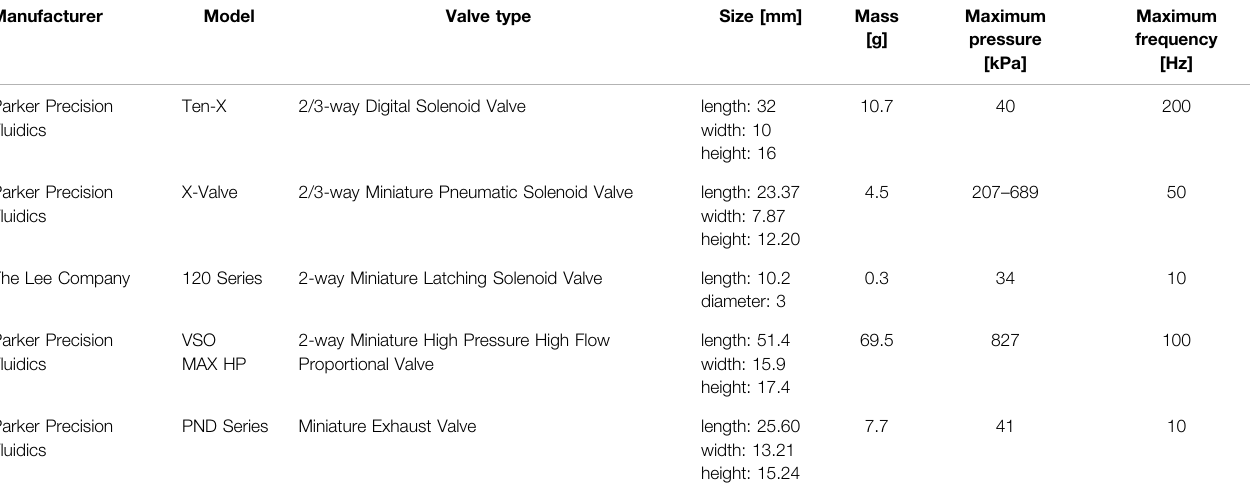
TABLE 1 | Summary of commercially available valves used in soft robots. Detailed information is available from the manufacturers ’ websites.